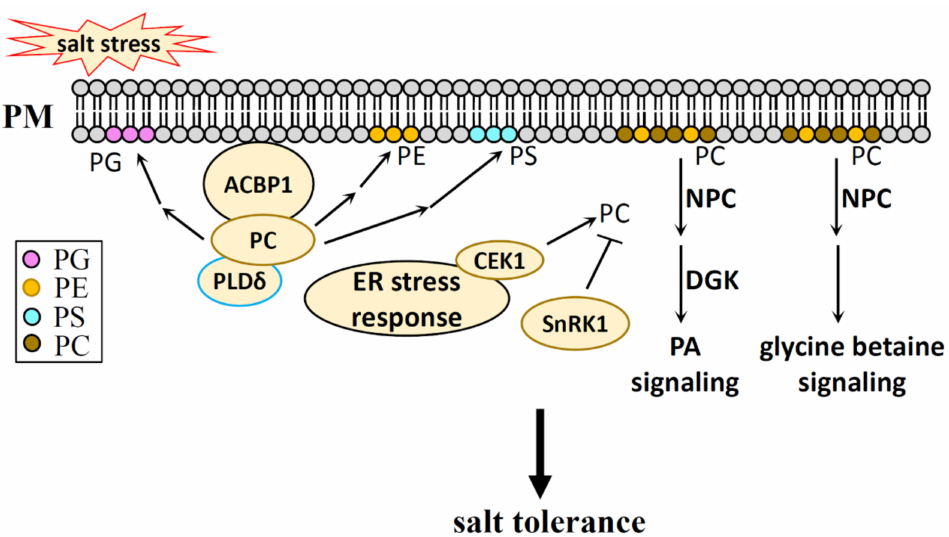
Figure 6. The regulatory role of PC and PE in the salt stress response of plants. PC improves plant salt tolerance by stabilizing the cell membrane through its conversion to PE, PS, PG, and ACBP1 and PLD δ mediate this process; The biosynthesis of PC can be regulated by SnRK1 and ER stress; The further hydrolysis of PC and PE can improce plant salt tolerance through the PA signaling and the glycine betaine signaling. PG, phosphatidylglycerol; PS, phosphatidylserine; PC, phosphatidylcholine; PE, phosphatidylethanolamine; PM, plasma membrane; ACBP1, Acyl-CoA-binding protein 1; PLD, phospholipase D; ER, endoplasmic reticulum; CEK1, choline/ethanolamine kinase 1; SnRK1; NPC, non-specific phospholipase C; DGK, diacylglycerol